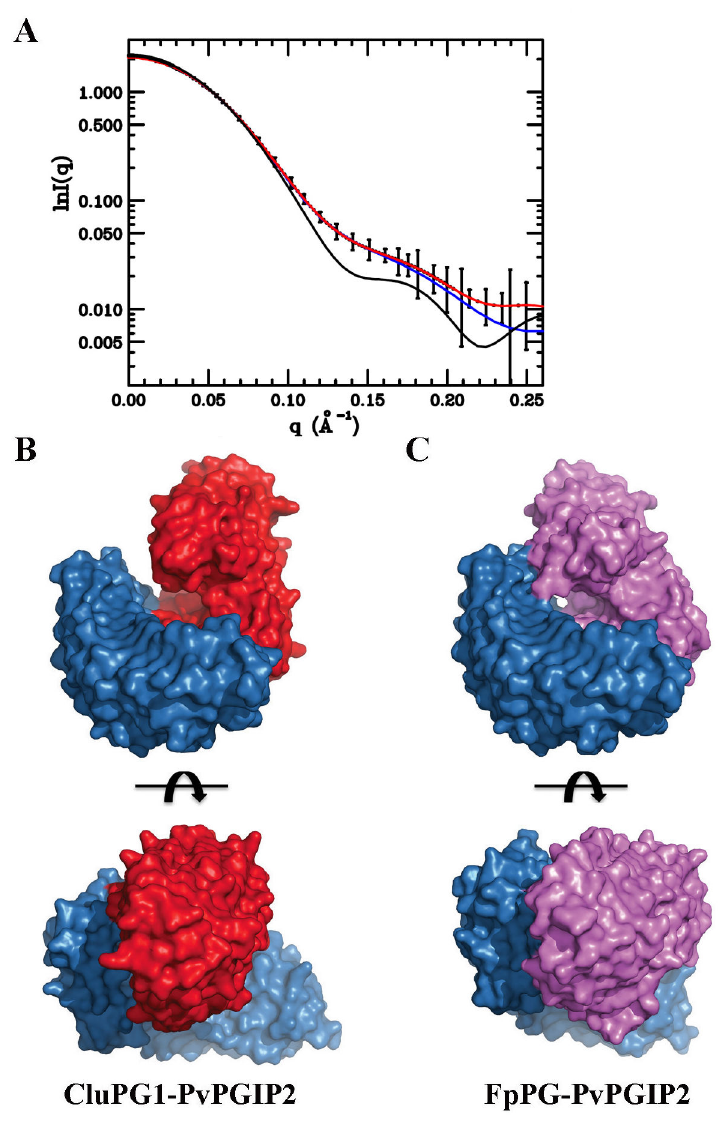
Figure 2. Comparative analysis between the CluPG1-PvPGIP2 and FpPG-PvPGIP2 complexes. A, The CluPG1-PvPGIP2 (red) and FpPG-PvPGIP2 scattering patterns (black) are reported together with the profile by the SASREF program for the CluPG1- PvPGIP2 complex (blue), for comparison. B, Surface representation of the complex formed by CluPG1 (in red) and PvPGIP2 (in blue). C, Surface representation of the complex formed by FpPG (in magenta) and PvPGIP2 (in blue). PvPGIP2 contacts both edges of the active site cleft in FpPG while only one edge is contacted in CluPG1. Two orthogonal viewpoints are reported.